Question: From the figure, is the trend upward or downward?
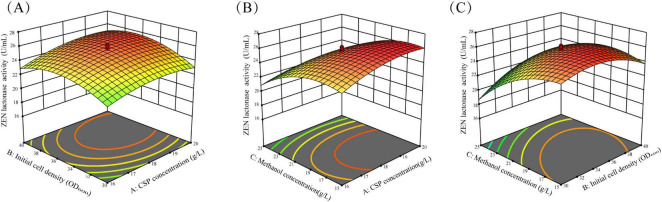
Answer: increasing